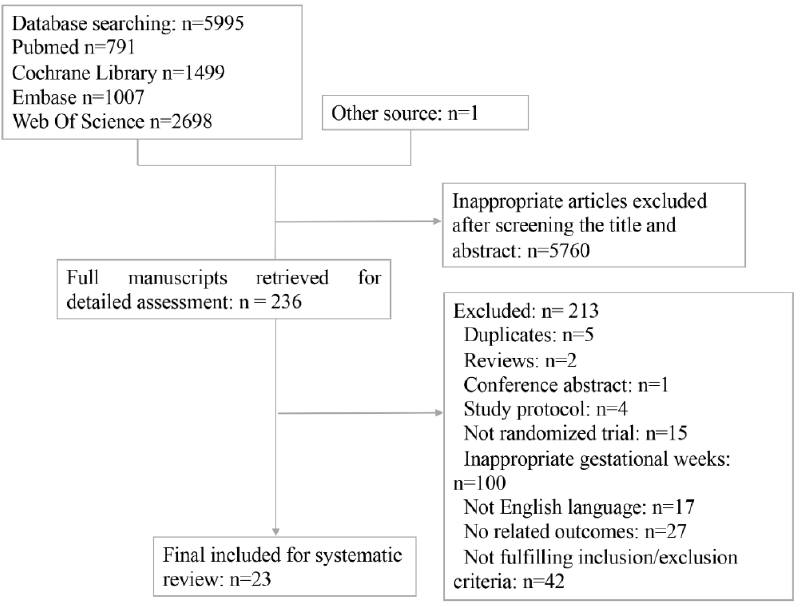
Figure 1. Flow chart of included studies in the network meta-analysis.